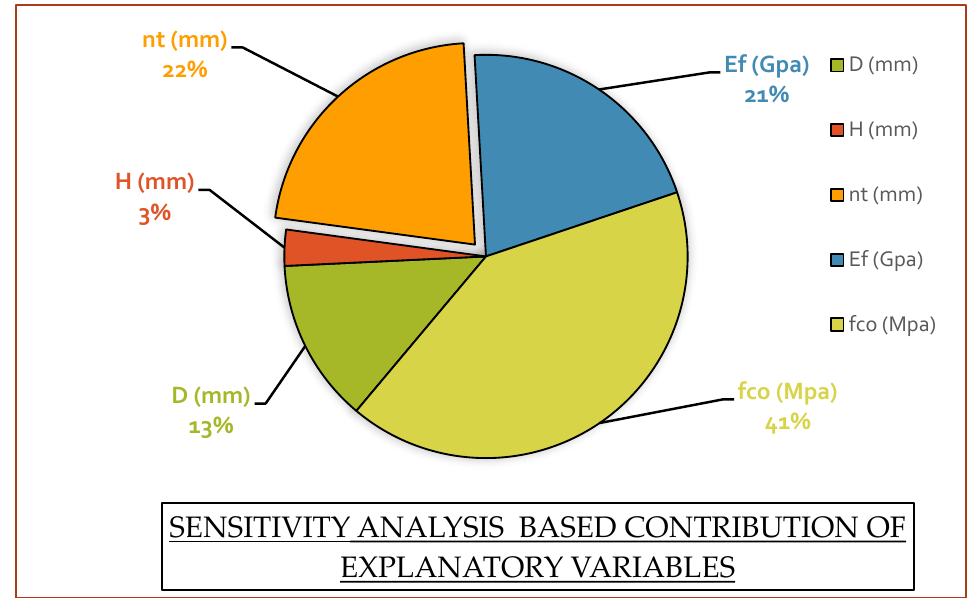
Figure 8. Sensitivity analysis based on the relative contribution of predictor variables.